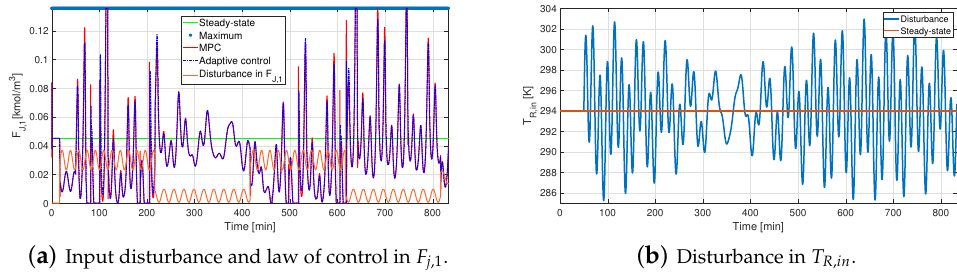
Figure 13. Variations in the auxiliary services: simultaneous Disturbances in F J ,1 and T R , in .